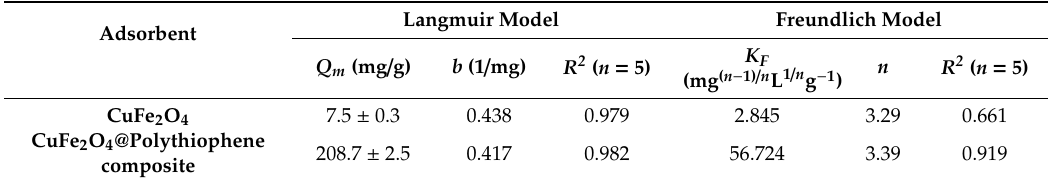
Table 3. Adsorption isotherm parameters achieved using Langmuir and Freundlich